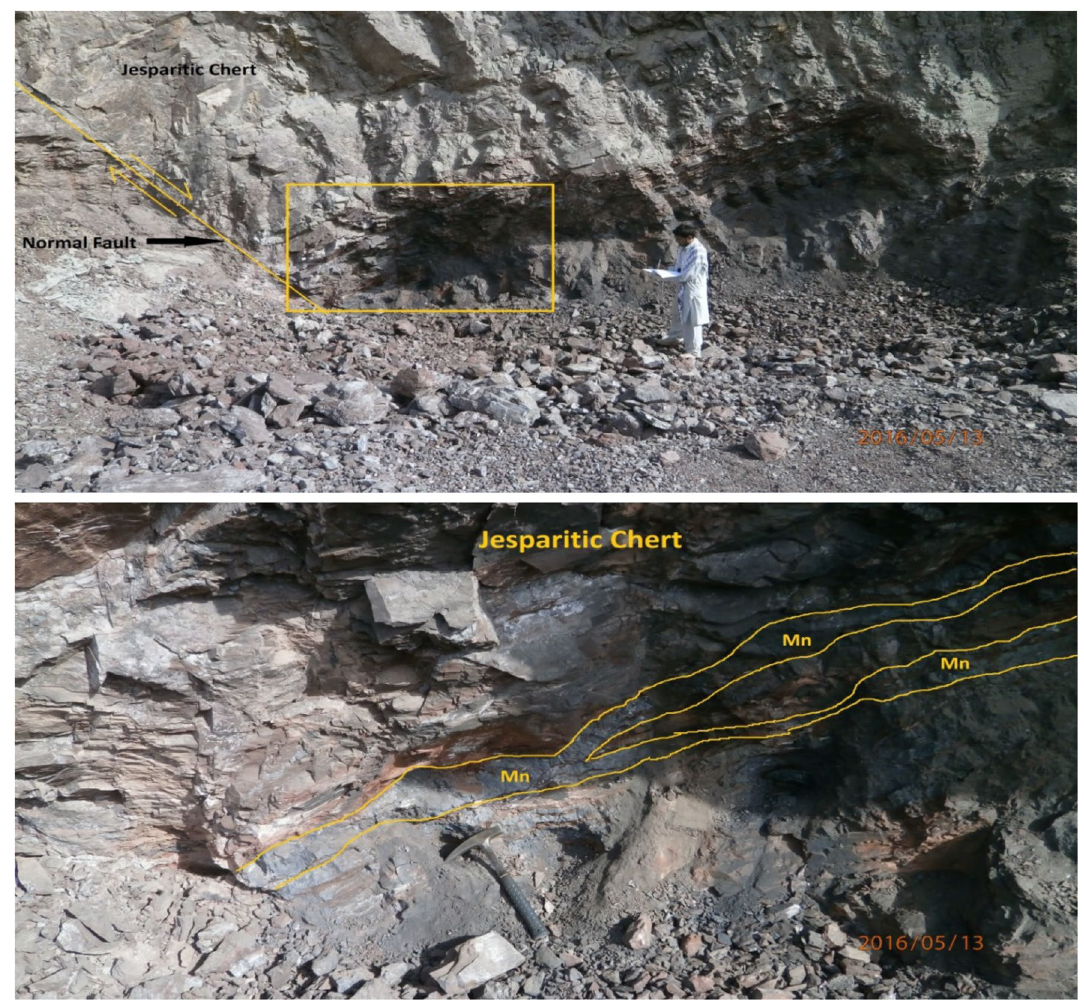
Fig. 2 Illustration shows the photograph of one location from where Mn ore samples were collected for analysis. The close capture of the area selected with rectangle is also shown